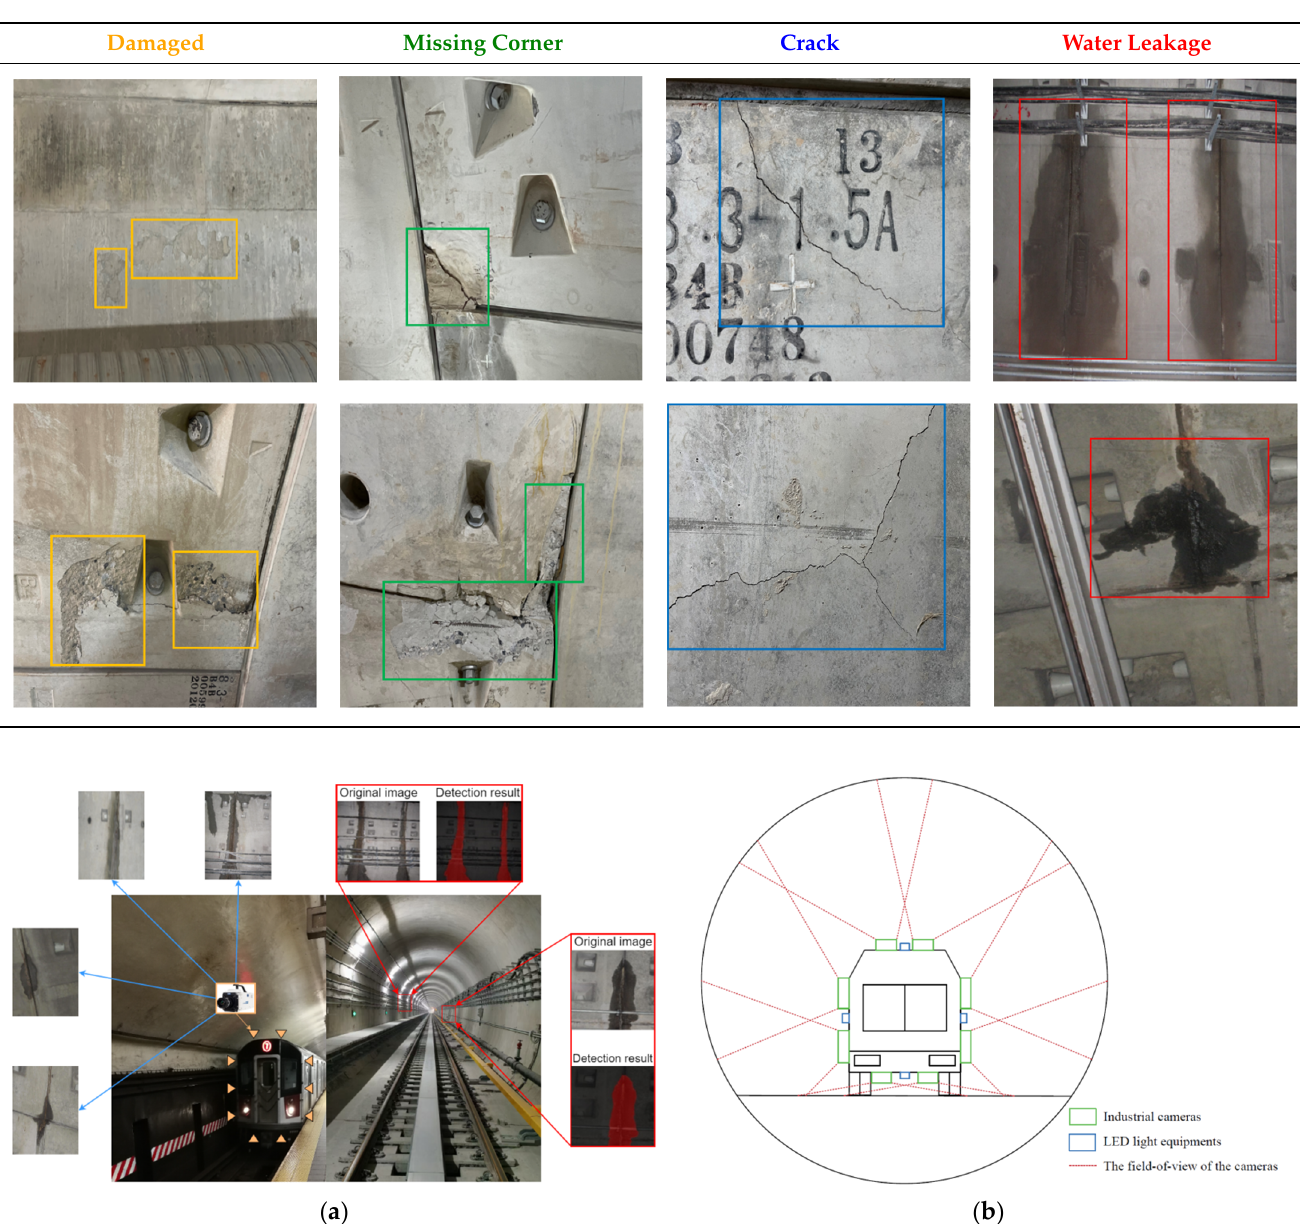
Table 1. Main diseases of subway tunnels.